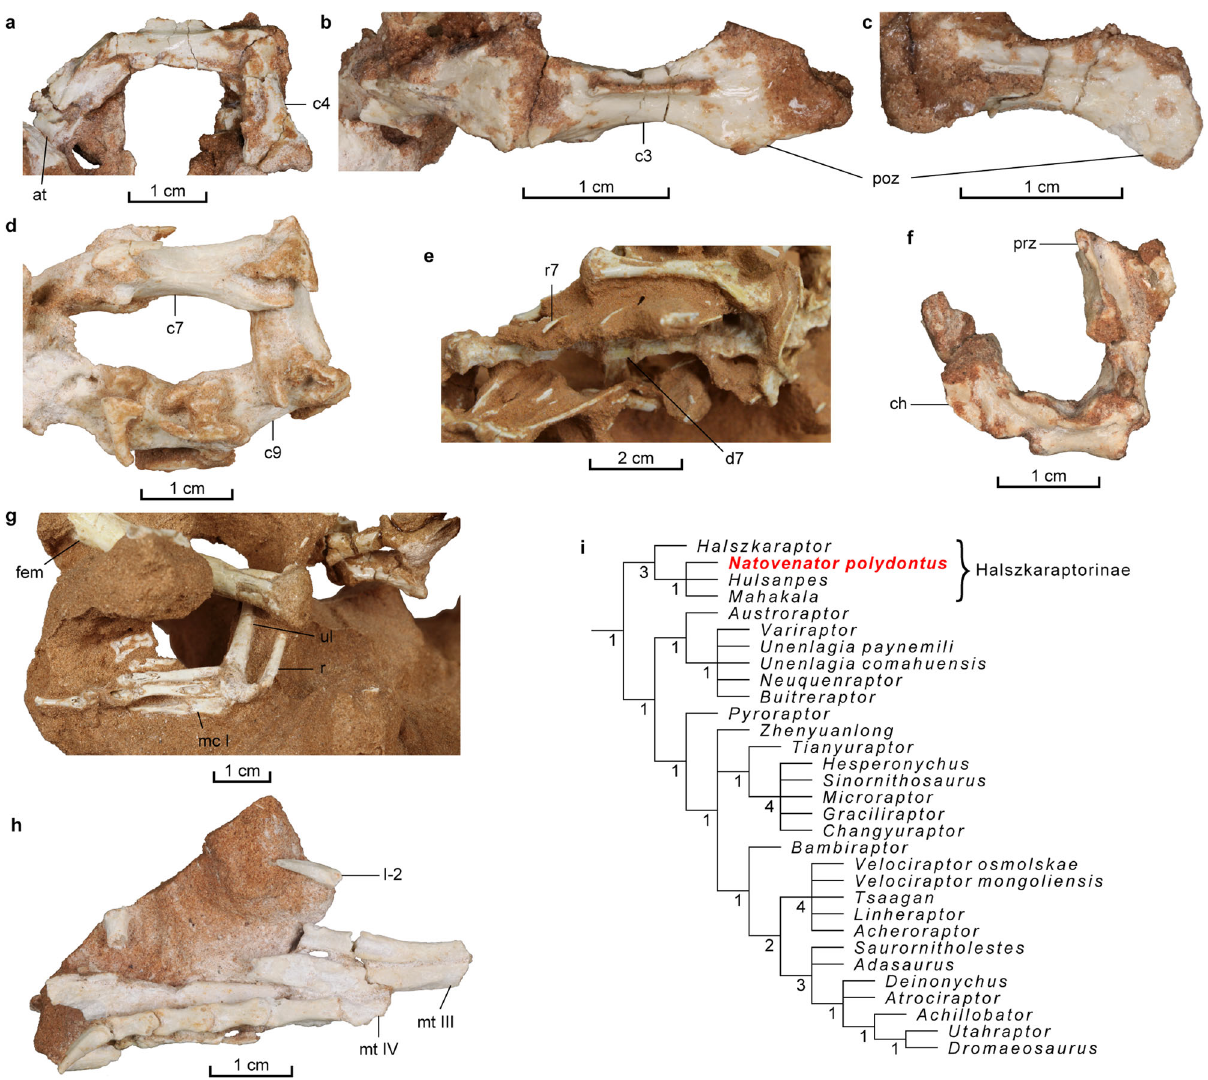
Fig. 3 Postcranial elements and phylogenetic position of Natovenator polydontus (MPC-D 102/114, holotype). a Anterior cervical vertebrae in left lateral view. b Axis and third cervical vertebra in dorsal view. c Fourth cervical vertebra in dorsal view. d Posterior cervical vertebrae in right lateral view. e Dorsal series in right lateral view. f Anterior caudal vertebrae in right lateral view. g Left forearm elements in medial view and manus in ventral view. h Right foot in ventral view. i Phylogenetic position of Natovenator in Dromaeosauridae. Numbers at each node indicate Bremer support values. at atlas, c3 third cervical vertebra, c4 fourth cervical vertebra, c7 seventh cervical vertebra, c9 ninth cervical vertebra, ch chevron, d7 seventh dorsal vertebra, fem femur, mc I metacarpal I, mt III metatarsal III, mt IV metatarsal IV, poz postzygapophysis, prz prezygapophysis, r radius, r7 seventh dorsal rib, ul ulna, I-2 pedal phalanx